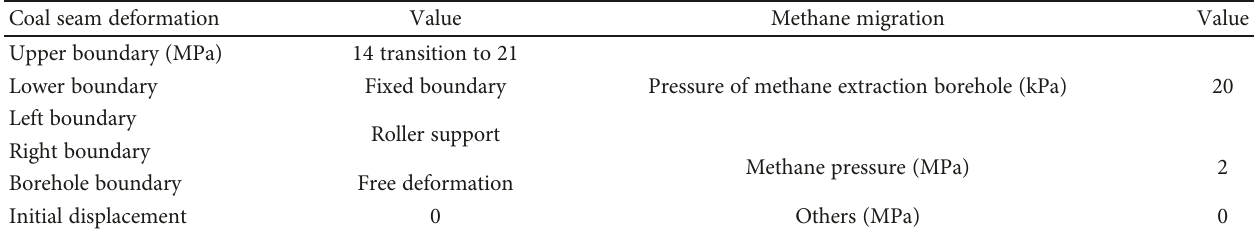
Table 2: Numerical model boundary conditions.